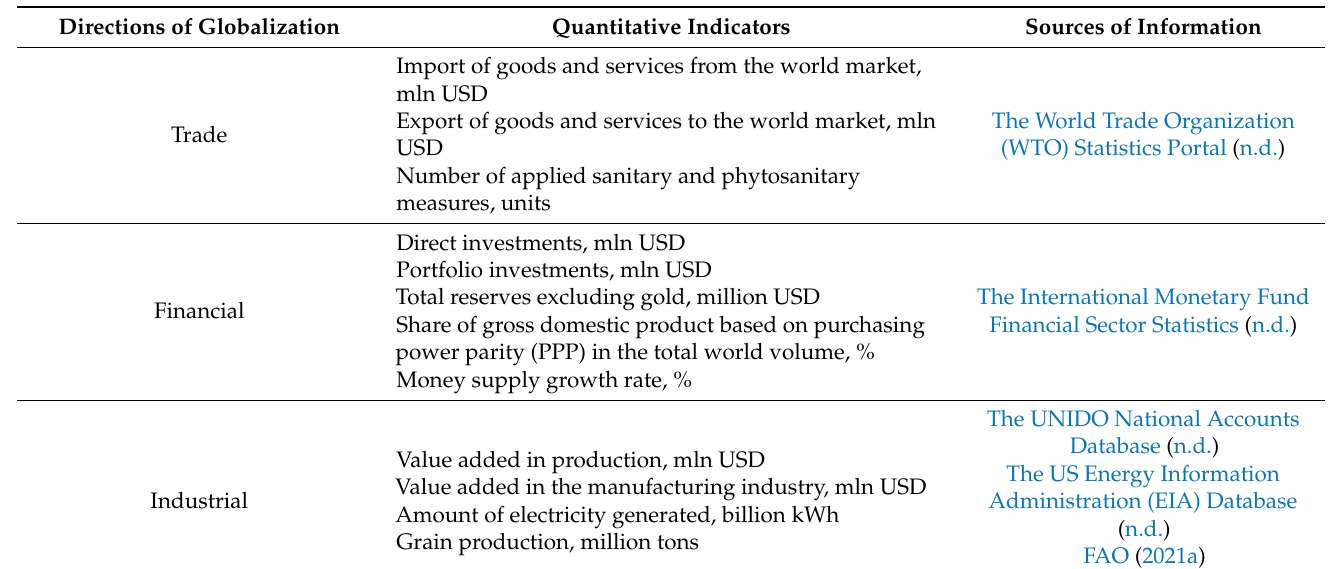
Table 1. Indicators of the country’s